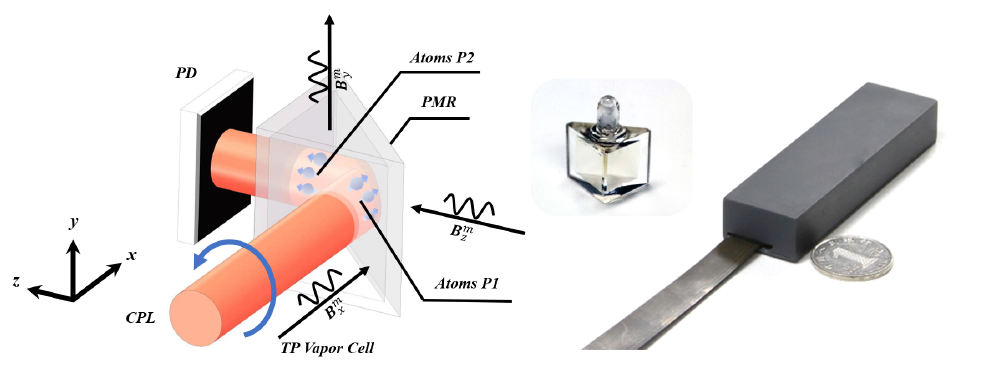
Figure 1. Schematic diagram for the triaxial magnetic field measurement. PMR: Polarization- maintaining reflector. CPL: Circularly polarized light. PD: Photodetector. The sensor and vapor cell images are on the right